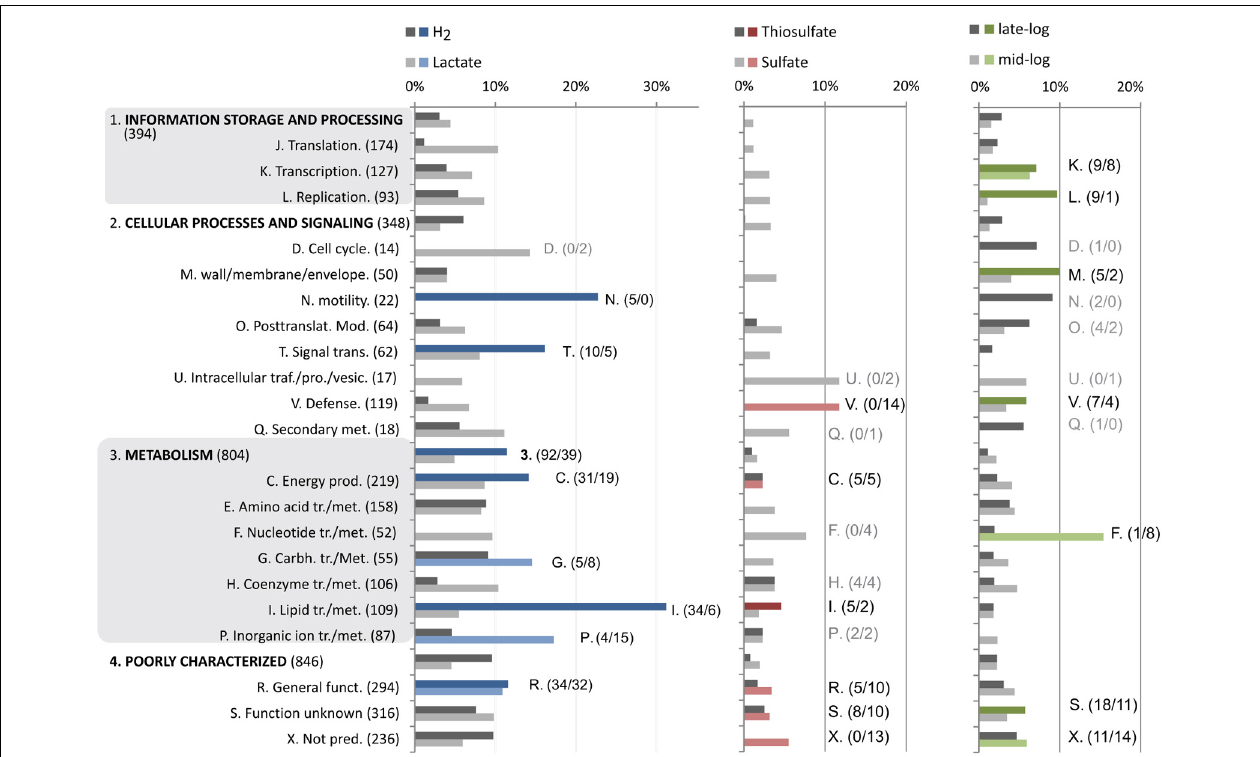
FIGURE 2 | Distribution and enrichment of COG categories that are differentially regulated corresponding to specific factors (Figure 1B). Bar plots display expression as percentage of each COG category. Bars highlighted with specific colors (as in Figure 1B ) correspond to